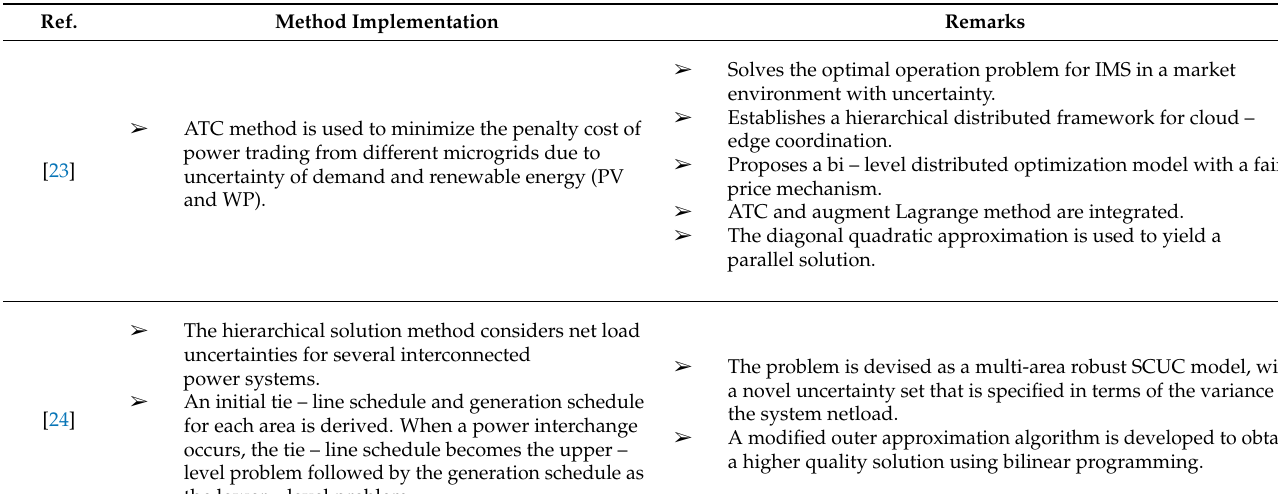
Table 15. Studies In Which The Hierarchical Scheduling Strategy Is